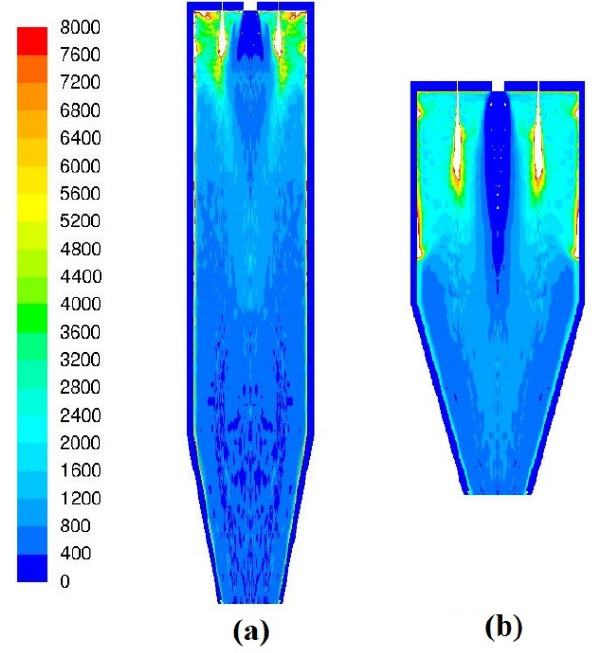
Figure 12. Particle number density (particles/cm 3 ) in the plane passing through the centers of two powder feeding ports: ( a ) design No. 1 and ( b ) design No. 3 under operating conditions listed in